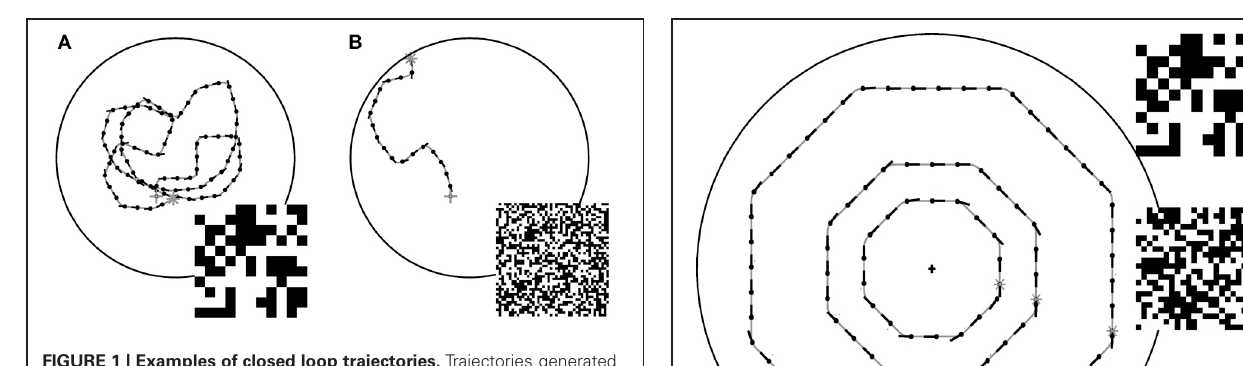
FIGURE 1 | Examples of closed loop trajectories. Trajectories generated by the CyberFly algorithm in a virtual flight arena covered with textures of different texel size (A) coarse pattern, (B) fine pattern (see insets). The starting conditions were the same for the two flights. The change of texture density is sufficient to cause a severe drop in wall avoidance performance. Data from Lindemann et al. (2012).